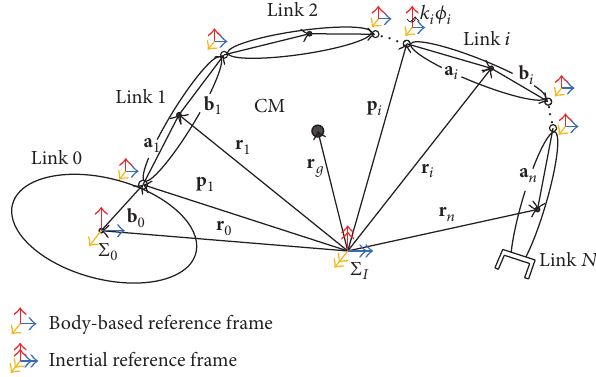
Figure 1: Structure diagram of a space-based manipulator